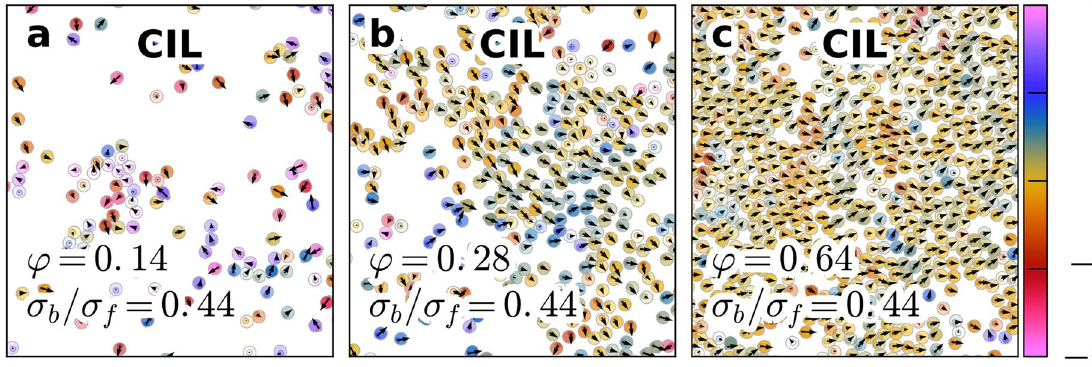
Figure 11. Disorder to order transition. Simulation snapshots of CIL cells with cell noise in steady states at different area fractions. The cell velocities are shown as arrows, and the colour hue indicates deviation from the average directions, with compressed cells indicated by a lighter colour. Cells randomly migrate at a low density ( a ), some coherency appears at an intermediate density ( b ), and highly coherent migration is observed at a high density ( c ). Videos for these systems are available in the Supplemental materials, which compare well with similar experimental videos for keratocytes 35